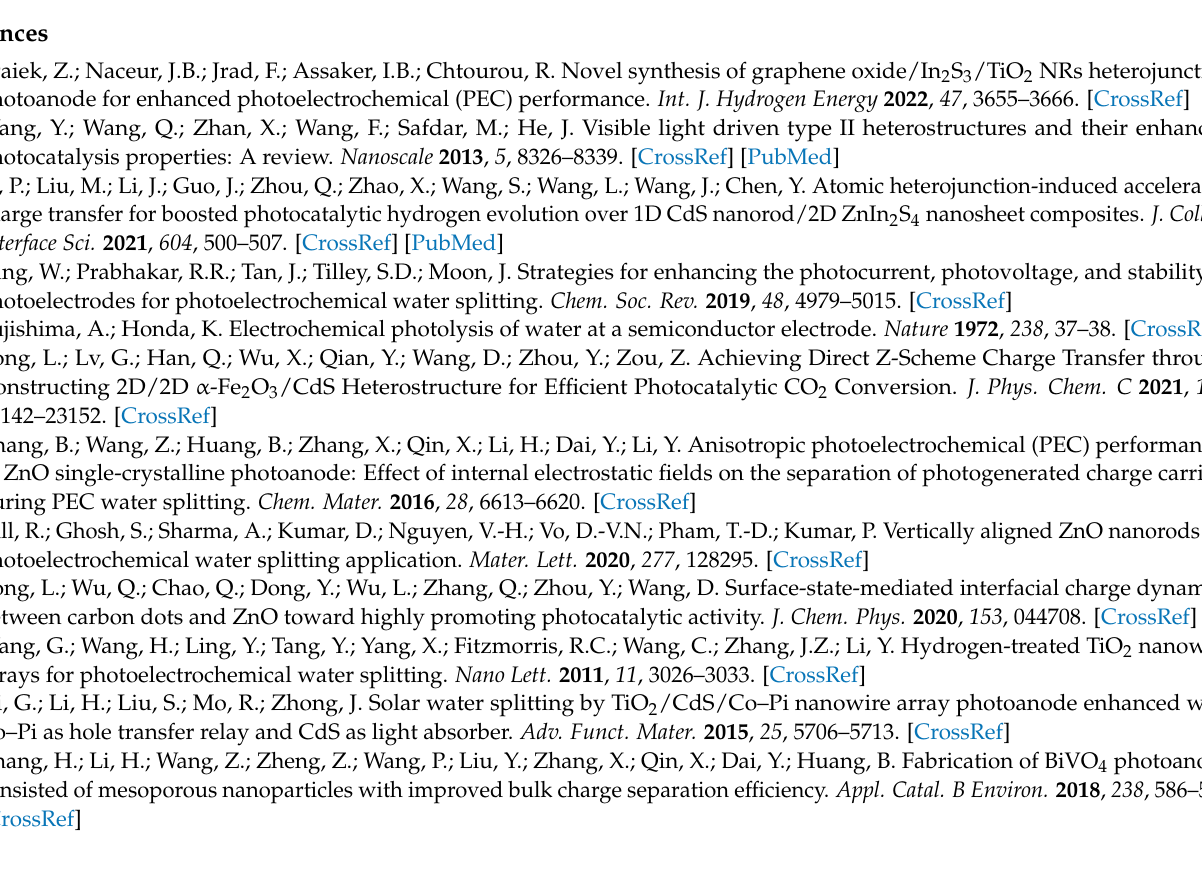
(HC); Figure S2. XRD patterns of ZIS (HC); Figure S3. Photocurrent density versus potential